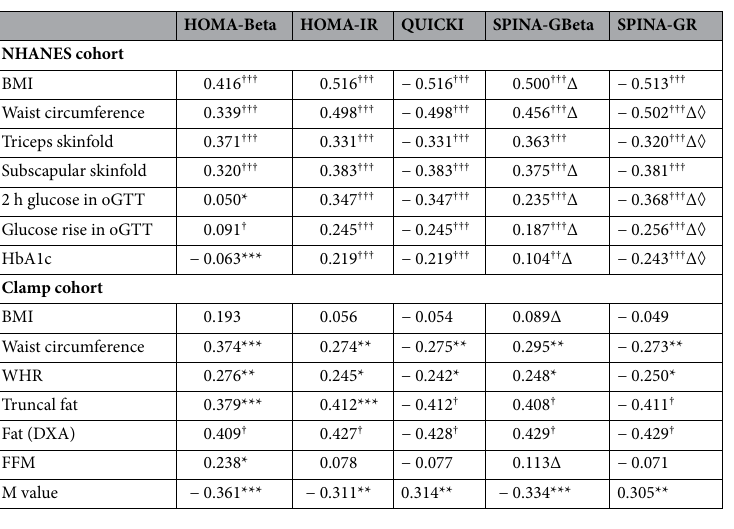
Table 4. Correlations of calculated biomarkers to somatometric data and response to oral glucose tolerance testing (NHANES cohort) or M-value (clamp cohort), respectively. Shown are rho values of Spearman’s rank correlation. p * < 0.05, ** < 0.01, *** < 0.001, † < 1e–4, †† < 1e–6, ††† < 1e–15 for correlations. ∆ Different from